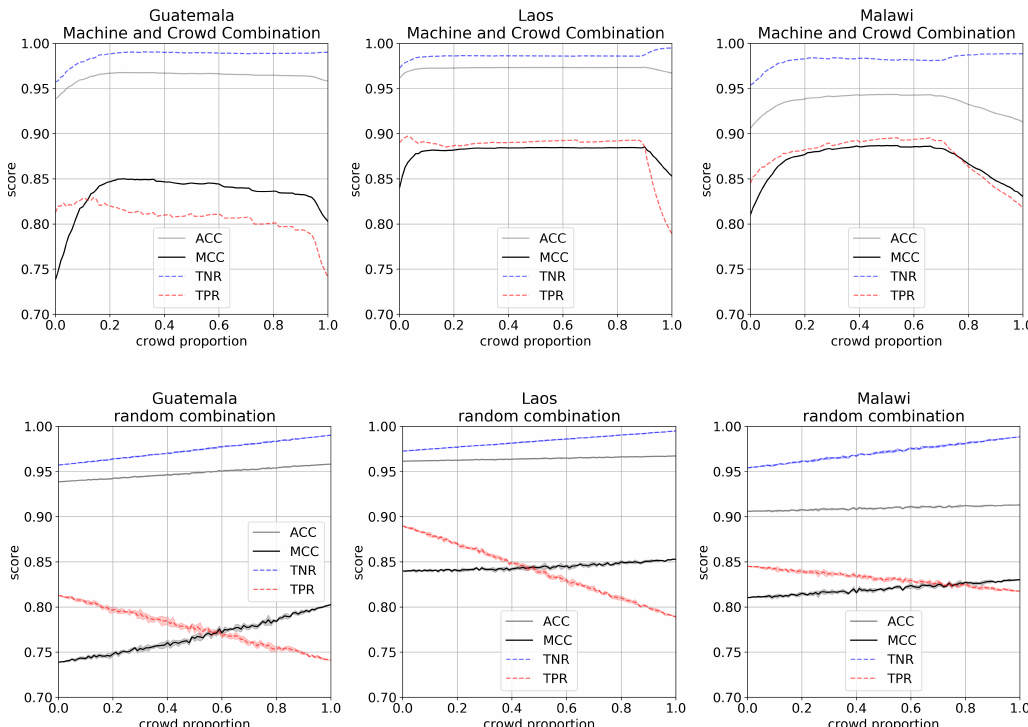
Figure 7. Data quality and effort in respect to crowd proportion and task allocation strategy for a combined MapSwipe-DeepVGI methods. The upper side of the figure represents the performance of the confidence score-based task allocation strategy, whereas on the bottom side the mean and standard deviation of the performance of 250 random allocations between DeepVGI and MapSwipe are shown. Performance is measured by accuracy (ACC), Matthew’s correlation coefficient (MCC), sensitivity (TPR) and specificity (TNR). The x-axis of the plot shows the crowd proportion. A crowd proportion of 0.0 (left) refers to DeepVGI. Consequently, the performance for a crowd proportion of 1.0 (right) refers to the performance of MapSwipe. For a crowd proportion of 0.3, 30% of the results are obtained from MapSwipe (these tiles refer to the DeepVGI tiles with the lowest confidence) and 70% from